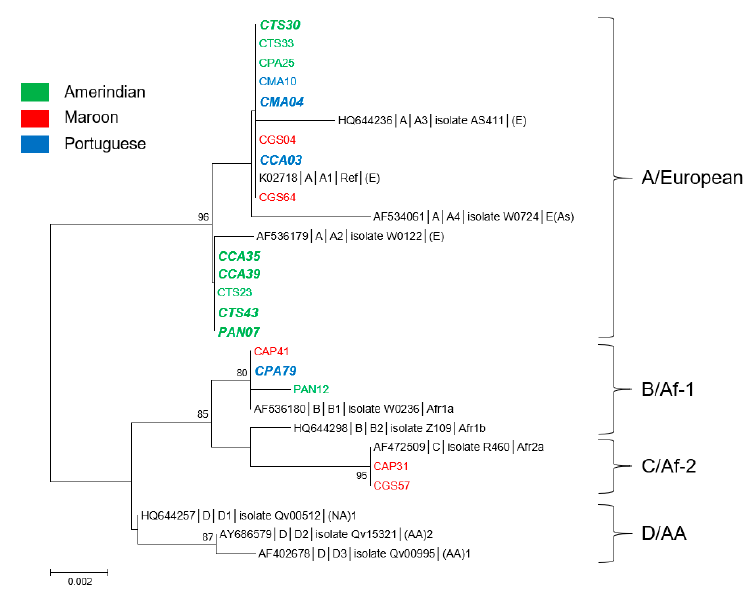
Figure 1. Phylogenetic tree of HPV16 variants from French Guiana. Maximum likelihood phylogenetic tree of HPV16 variants based on 747 bp of E6 and E7 concatenated sequences. Four clusters were identified as lineages A, B, C, and D. Only bootstrap values above 70% are represented in the branches. The tree is drawn to scale with branch lengths measured in the number of substitutions per site. Newly generated sequences, here identified by their IDs, are color-coded according to the mother tongue of the women from whom they were obtained. Oversized sequences in bold and in italics are those obtained from women with an abnormal cytology (either Atypical Squamous Cells of Unknown Significance (ASCUS), Atypical Squamous Cells, cannot exclude high grade lesion (ASC-H), Low Grade Squamous Intraepithelial Lesion (LSIL), High Grade Squamous Intraepithelial Lesion (HSIL), or glandular anomalies).